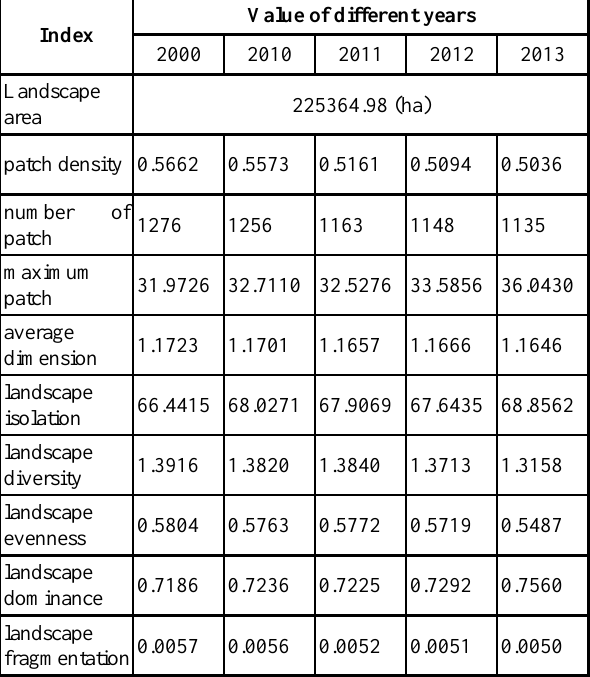
Table 5. Landscape structure changes from 2000 to